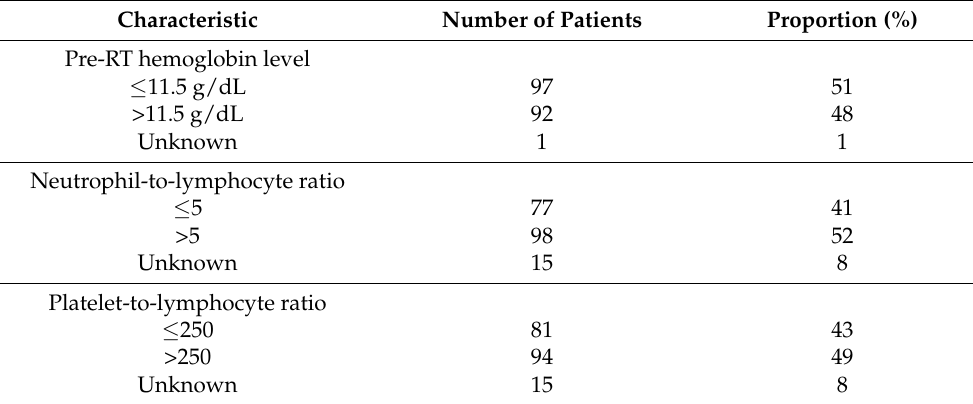
Table 3. Characteristics investigated for associations with